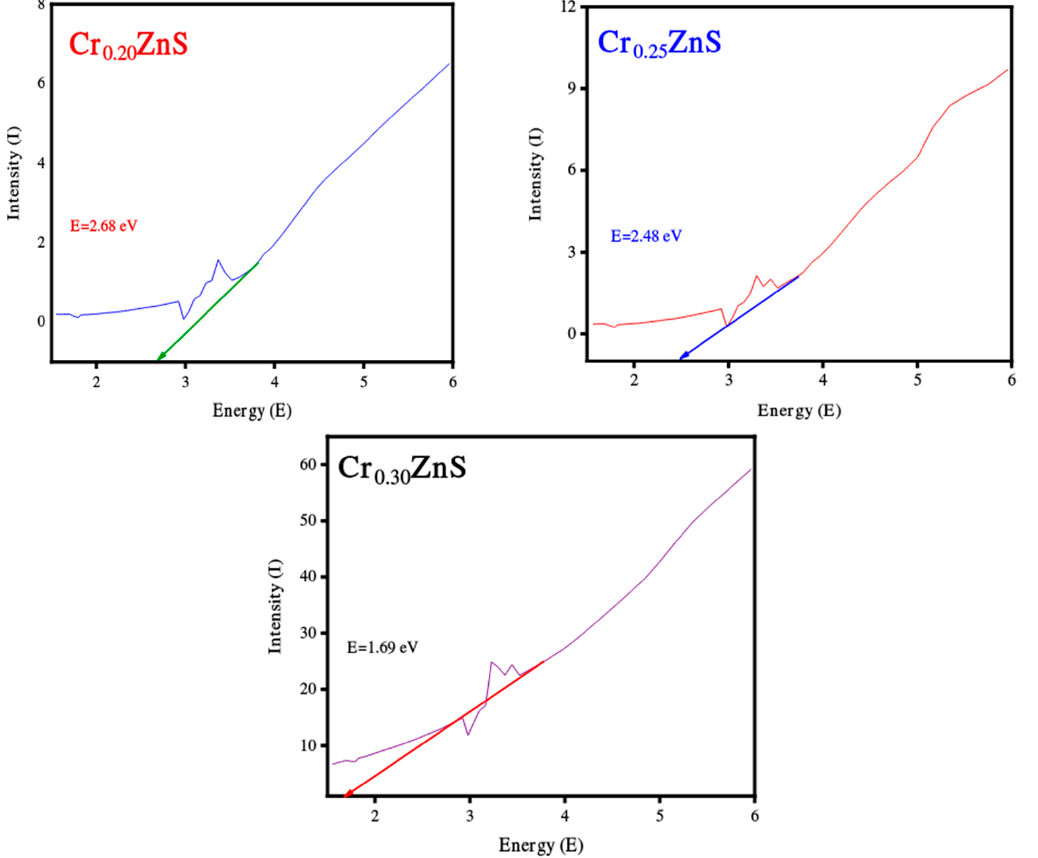
Figure 4. UV-Vis absorbance spectra of Cr x ZnS (x = 0.20, 0.25, and 0.30) catalyst. The band gap values of the catalysts with different Cr compositions are reported in Figure 5. The band gap of Cr x ZnS with x = 0.20, 0.25, and 0.30 was found to be 2.68, 2.48, and 1.69 eV, respectively. These band gap values are lower than the standard value of bulk ZnS (3.6 eV) [23].